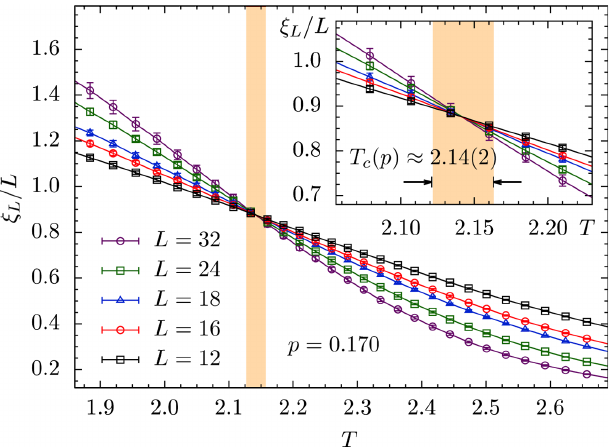
FIG. 5. Crossing of the correlation function (cid:7) L =L for the toric code with a disorder rate of p ¼ 0 : 170 . The data exhibit a clear crossing at a transition temperature of T c ð p Þ (cid:5) 2 : 14 ð 2 Þ . Corrections to scaling are still minimal at this disorder rate, but they increase closer to the error threshold. Inset: Close-up of the area where the crossing occurs. The conservative estimate for the transition temperature is indicated by the vertical shaded